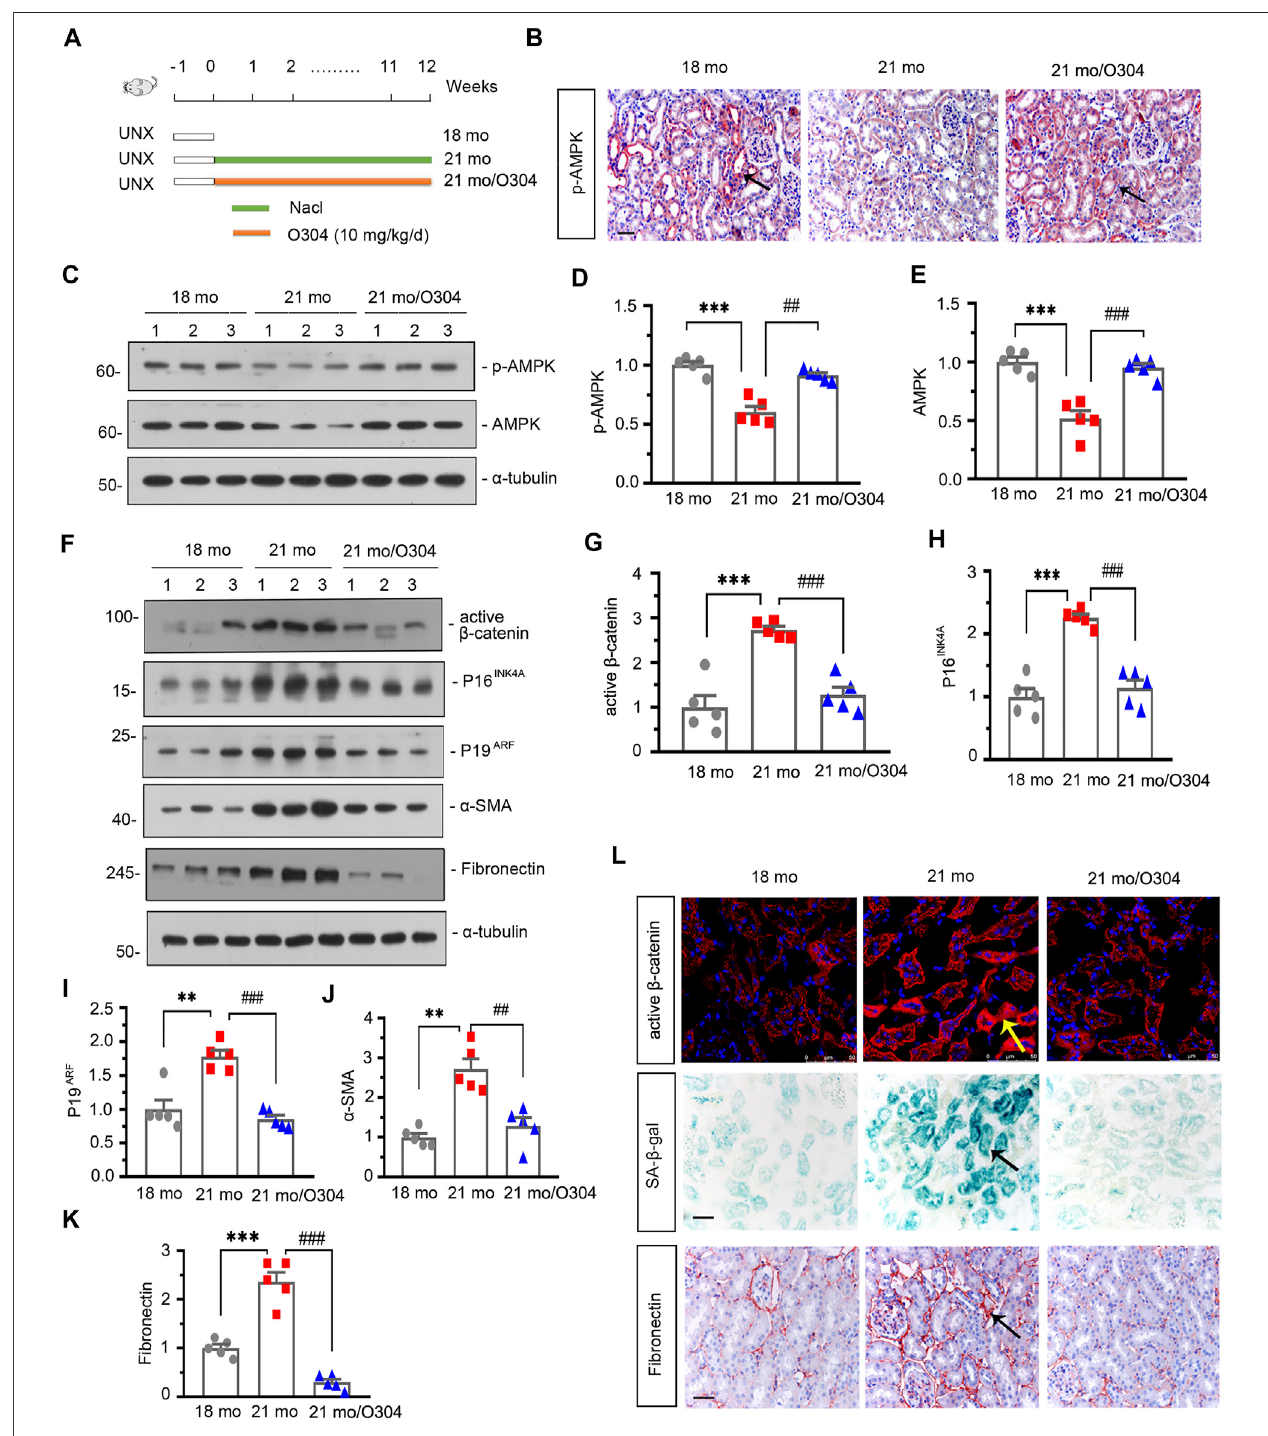
FIGURE3| O304couldactivateAMPK,alleviaterenalsenescenceand fi brosis,andinhibit β catenininnaturallyagingmice. (A) Experimentaldesign.Whitebarindicatedthe timeafterthesurgerywas1 week.Greenbarindicatedmicewereadministeredintraperitonealinjectionsof0.9%sodiumchloridesolutionfor12 weeksaftersurgery.Orangebar indicated mice were administered intraperitoneal injections of O304 at 10 mg/kg/day for 12 weeks after surgery. UNX: unilateral nephrectomy. (B) Representative micrographs showingrenalexpressionofp-AMPKindifferentgroups.Paraf fi n-embeddedkidneysectionswereimmunostainedwithantibodyagainstp-AMPK.Arrowsindicatepositive staining. Scale bar, 50 μ m. (C – E) Representative western blot and quantitative data showing renal expression of p-AMPK and AMPK in different groups. Numbers (1 – 3) indicate each individual animal in each given group. *** p < 0.001 versus 18-month-old mice group. ## p < 0.01, ### p < 0.001versus 21-month-old mice group alone ( n = 5). (F – K) Representativewesternblotandquantitativedatashowingrenalexpressionofactive β -catenin,P16 INK4A ,P19 ARF , α -SMAand fi bronectinindifferentgroups.Numbers(1 –